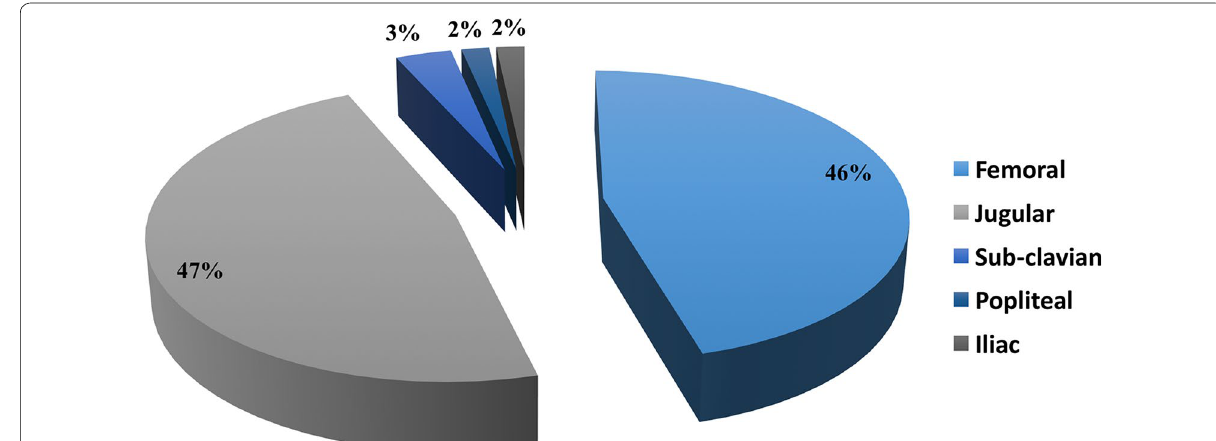
Fig. 3 Anatomical situation of DVT diagnosed with duplex US examination ( n subclavian ( n